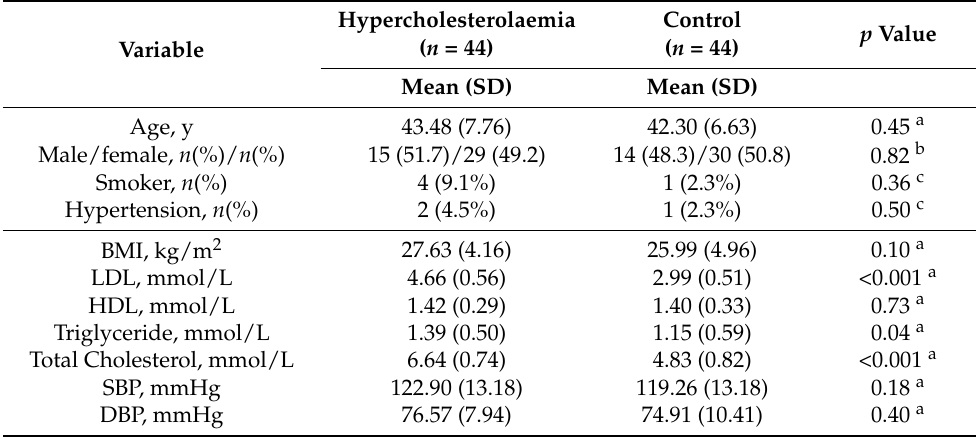
Table 1. Subjects